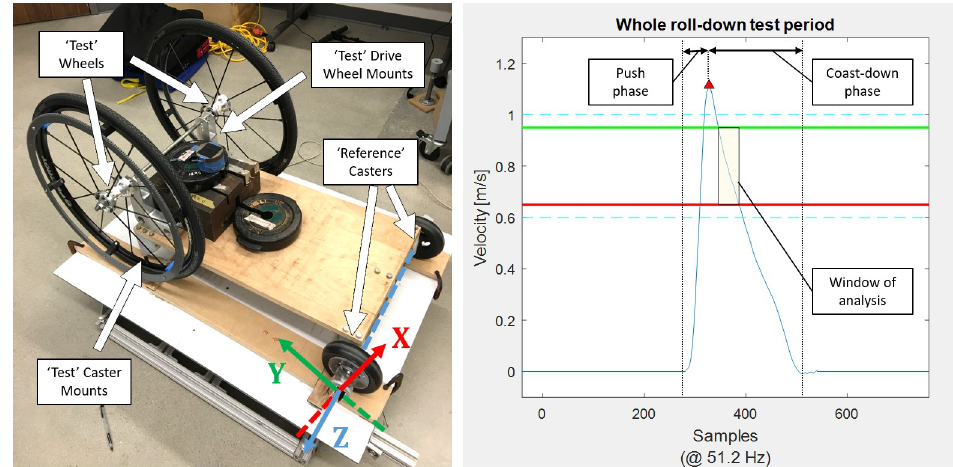
Fig 3. Coast-down cart. (Left) Standard loading on coast-down cart for testing drive wheels. The front casters are the ‘reference’ wheels with equipped accelerometer mounts. (Right) Representative linear velocity of the cart during a single trial. The window of analysis to determine the deceleration value is between 0.95 m/s and 0.65 m/s, denoted by the yellow shaded box.